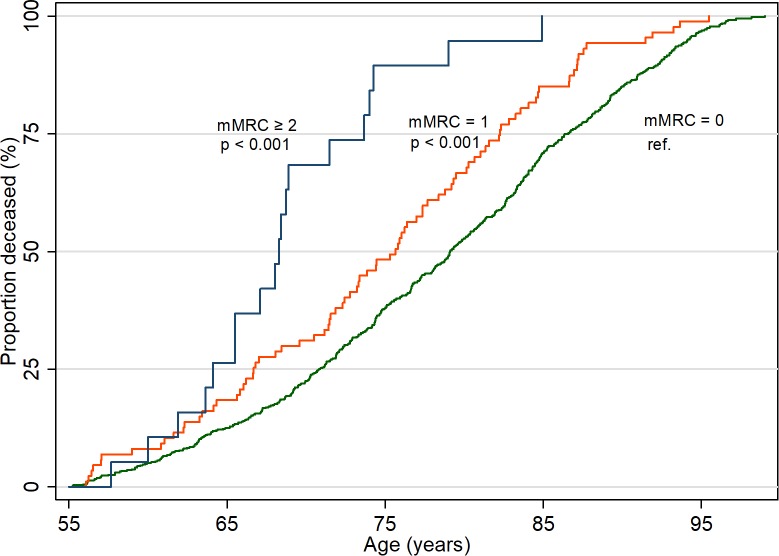
All-cause mortality per modified Medical Research Council (mMRC) grade from age 55 and throughout life.P-values were calculated using log rank tests.